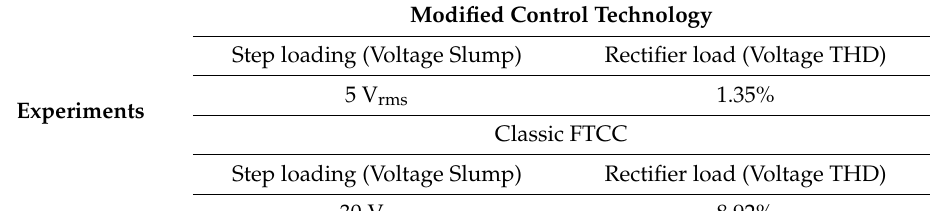
Figure 14. Experimental waveform under a rectifier load for the classic FTCC (100 V/div; 25 A/div; 5 ms/div). Table 3. Experimental output-voltage slump and voltage THD under a step loading and a rectifier load.